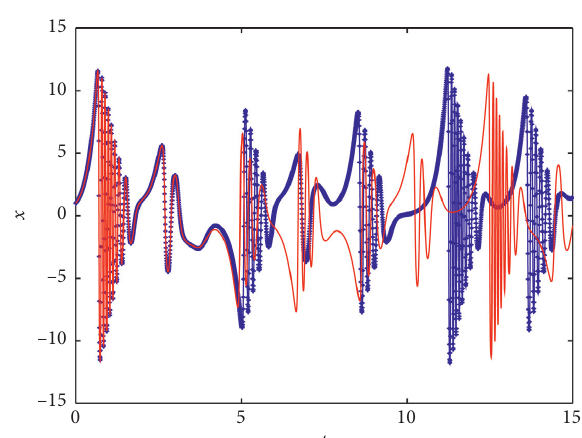
Figure 23: Sensitivity due to the variation of z ( 0 ) from z ( 0 ) � 1 to z ( 0 ) � 1 .